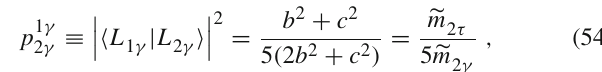
Fig. 5 In the TM1 μ - τ reflection symmetry scenario and the case of < M M , for some benchmark values of M 2 1 plotted lines), the values of ϑ versus the lightest neutrino mass for lep-